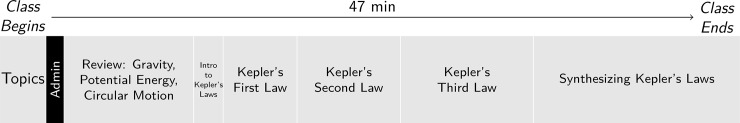
Example recording showing segments, the unit of analysis used in coding for the opportunity to engage students in 3DL.Segments from the recording of an example physics class session (47 minutes total) are identified by topic and depicted from class start to class end (left to right) by relative time duration (horizontal length represents the relative time of the segment with respect to the class session total).